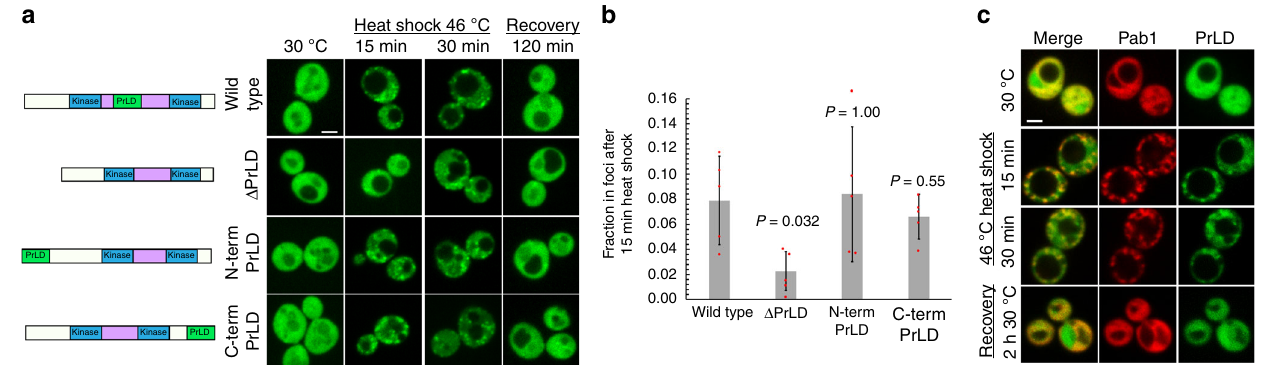
Fig. 2 Sky1 ’ s PrLD promotes Sky1 recruitment to stress granules. a Analysis of yeast expressing from the endogenous SKY1 locus GFP-tagged Sky1 mutants in which the core PrLD (amino acids 388 – 457) was deleted ( Δ PrLD), or moved to the N terminus (N term PrLD) or C terminus (C term PrLD). Cells were grown to mid-log phase and subjected to heat shock and recovery. A schematic of each mutant is shown. Scale bar, 2 μ m. b Quanti fi cation of the fraction of Sky1 in stress granule foci after 15 min of heat shock. Data represent mean ± SD from of n = 5 independent replicates. A two-sided Mann – Whitney U test was used to calculate P values. c The Sky1 PrLD is suf fi cient to associate with stress granules. Yeast expressing Pab1-mCherry from the endogenous locus were transformed with plasmids expressing the Sky1 PrLD fused to GFP, under control of the SUP35 promoter. Cells were visualized by fl uorescence microscopy during heat shock at 46 °C and recovery at 30 °C. Scale bar, 2 μ m. Source data are provided as a Source Data